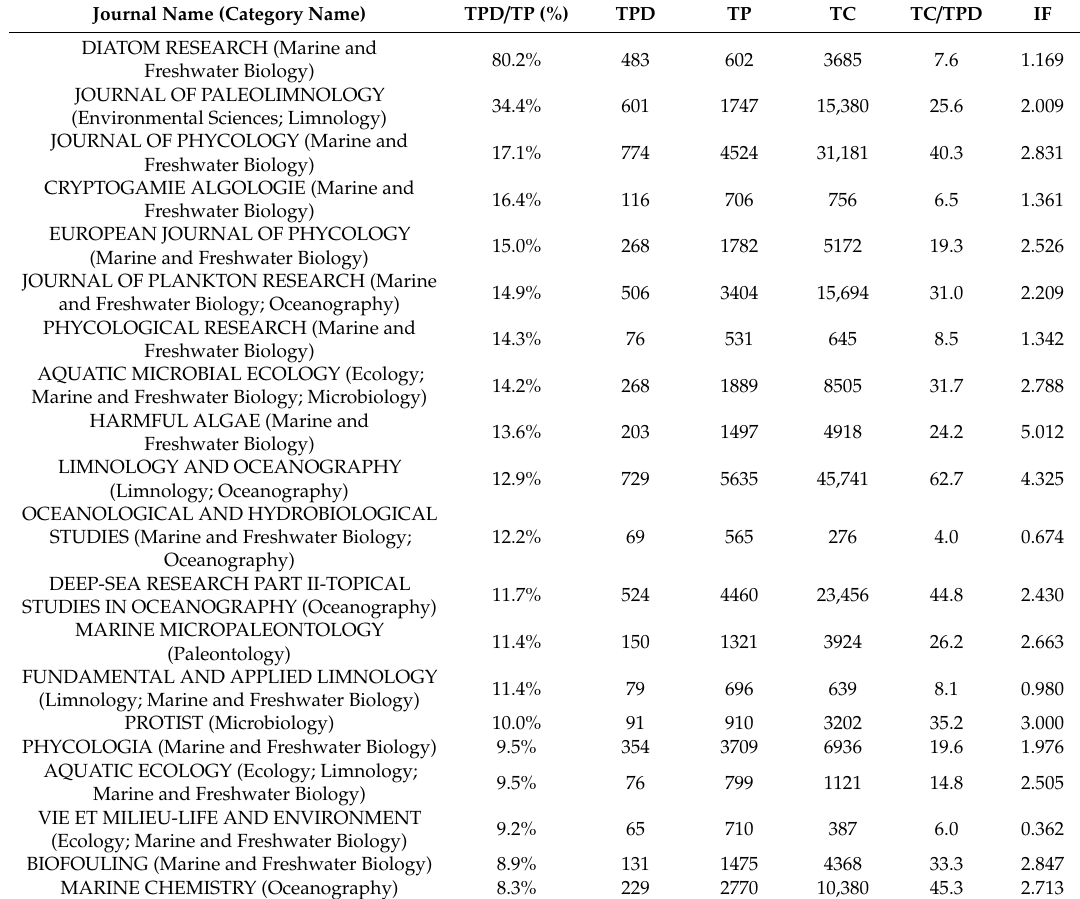
Table 1. The top 20 most active journals on diatom research from 1991 to